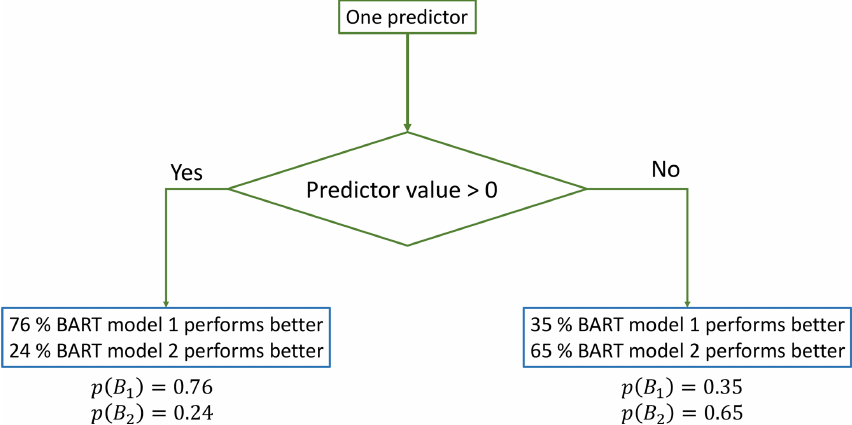
Figure 2. Schematic diagrams of an example of nesting two BART models under a simple two-leveled CART model, using only one predictor. The partitioning rule is expressed in the diamond box, and the leaves are represented in blue boxes.